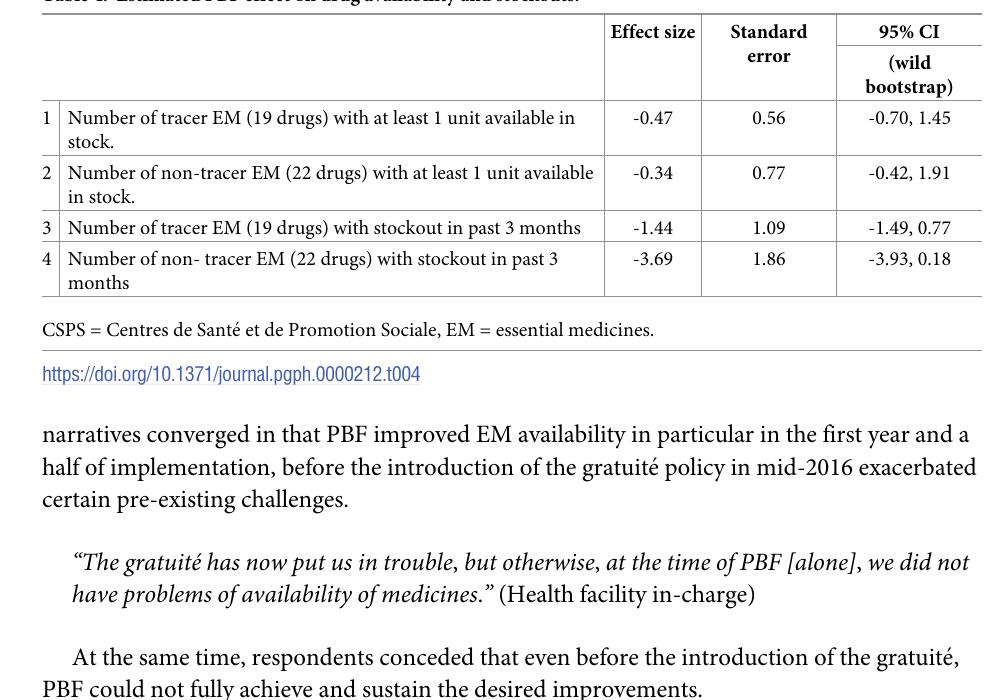
Table 4. Estimated PBF effect on drug availability and